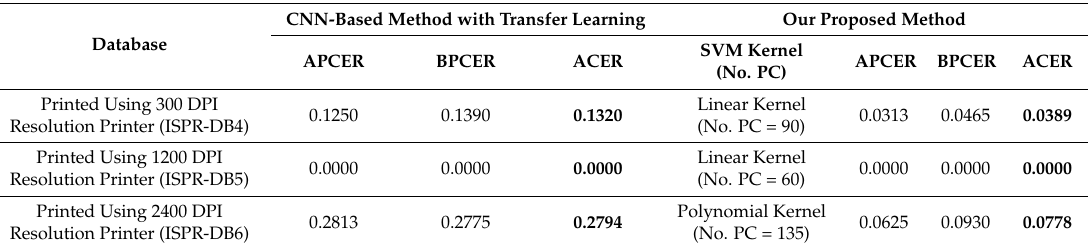
Table 15. Detection errors of our proposed method using Alex network architecture in Table 2 on sub-databases of ISPR-DB based on printing resolutions (unit: